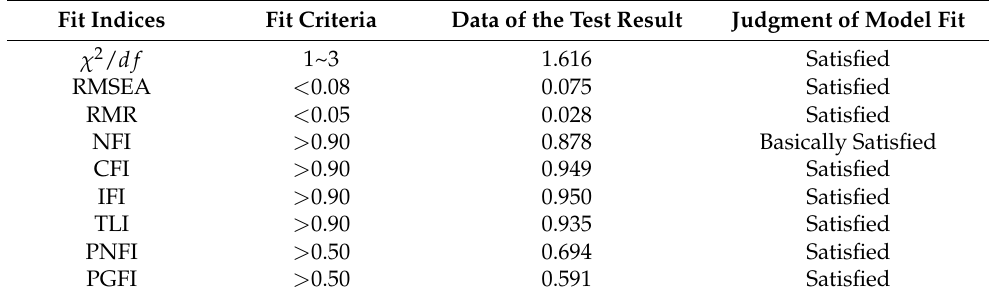
Table 4. Structural equation model fit indices.